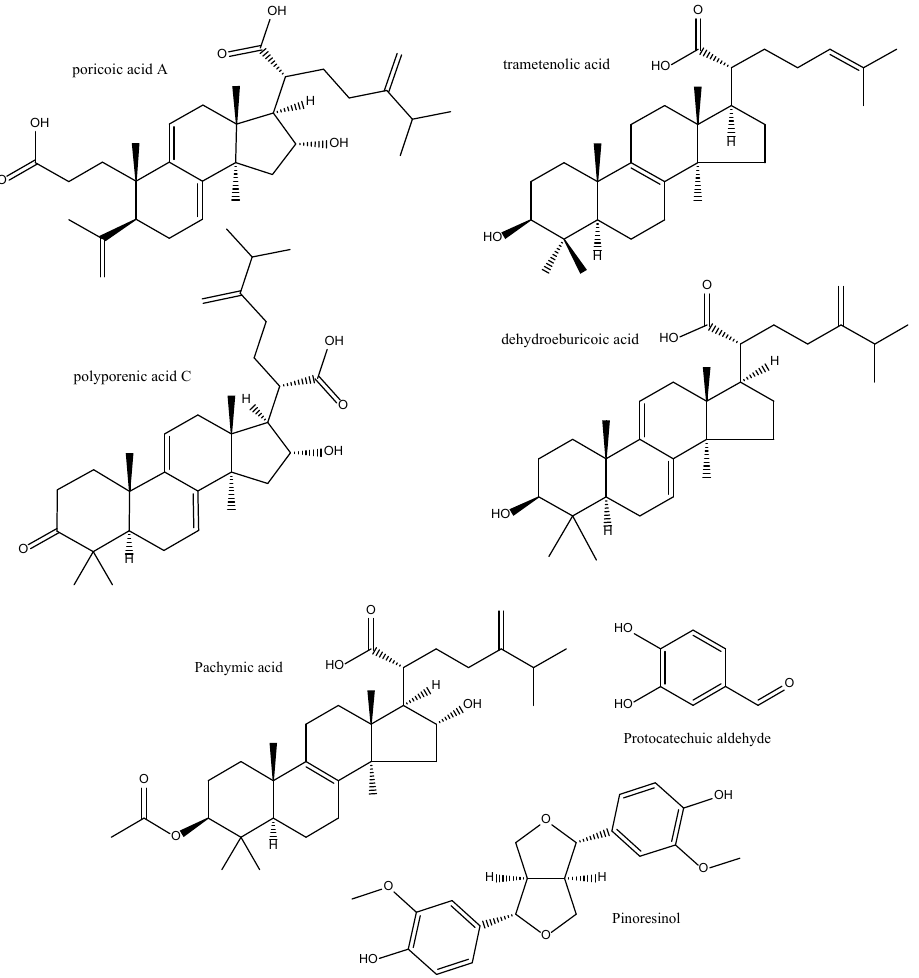
Figure 13. Bioactive anti-inflammatory (eicosanoid inhibition) and antioxidant principles from Poria cocos .